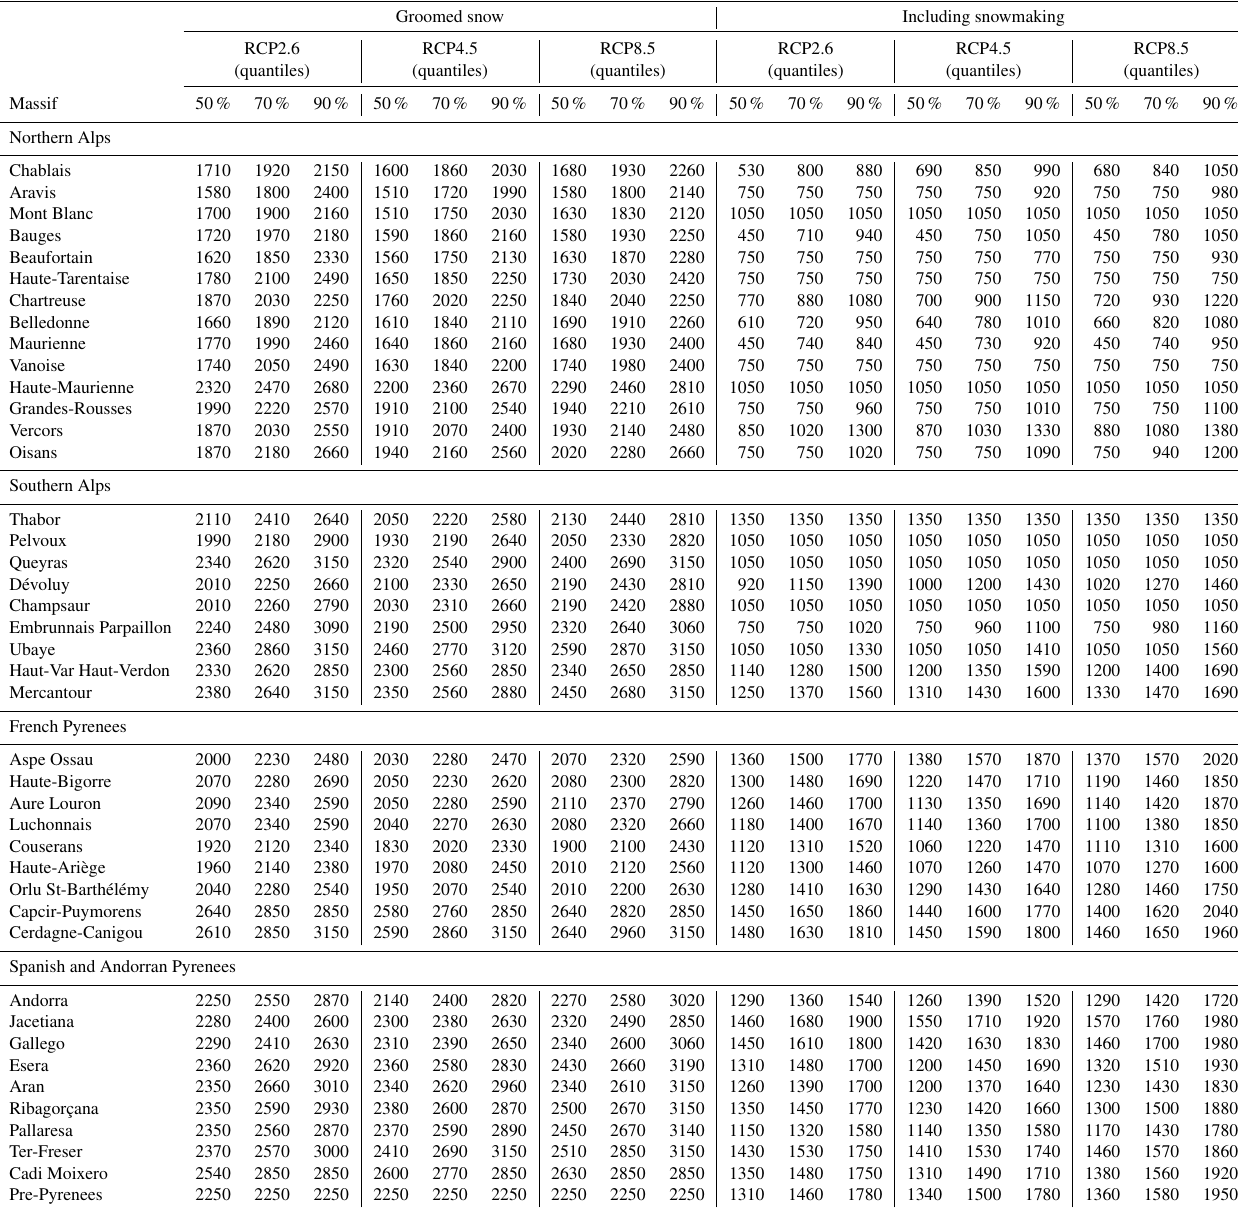
Table A2. Snow reliability elevation for the near future (2030–2050) for the 42 massifs distributed over the northern Alps, southern Alps, French Pyrenees, and Spanish and Andorran Pyrenees, computed by climate models for the RCP2.6, RCP4.5 and RCP8.5 and for three reliability requirements (50%, 70% and